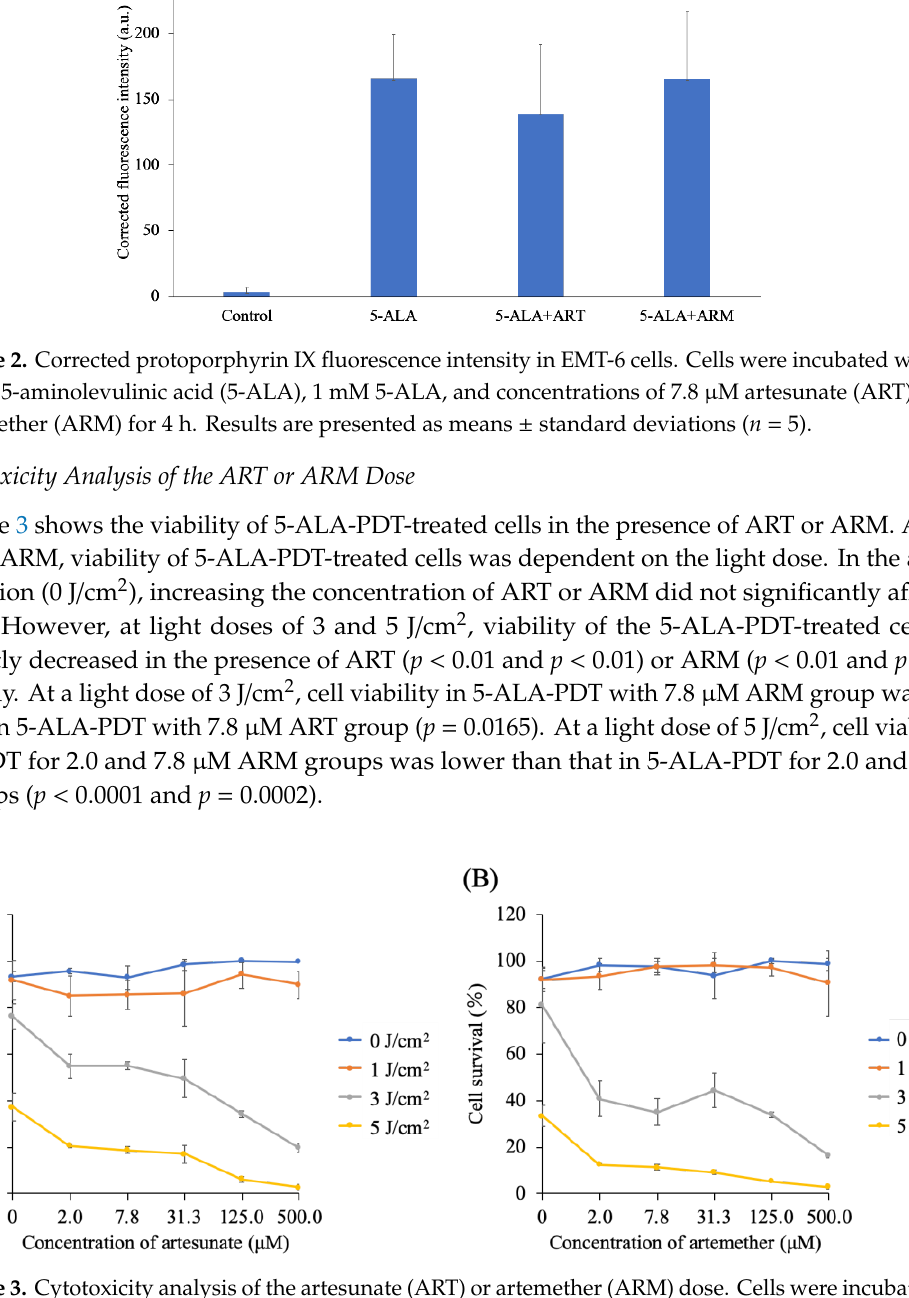
Figure 1. Protoporphyrin IX fluorescence in EMT-6. Cells were incubated with 1 mM 5-aminolevulinic acid (5-ALA) ( A , D , G ), and 1 mM 5-ALA plus concentrations of 7.8 μM artesunate ( B , E , H ) or artemether ( C , F , I ) for 4 h. Transmission, fluorescence, and merged images of EMT-6. Upper panel ( A – C ): Transmitted light images. Middle panel ( D – F ): Fluorescence images. Lower panel ( G – I ): Merged images. Scale bar = 20 μm.